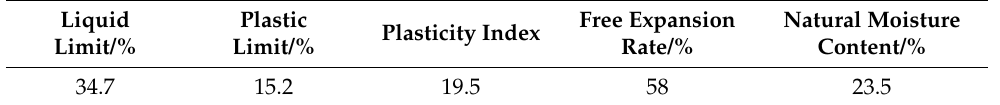
Table 1. Basic physical indicators of soil samples.